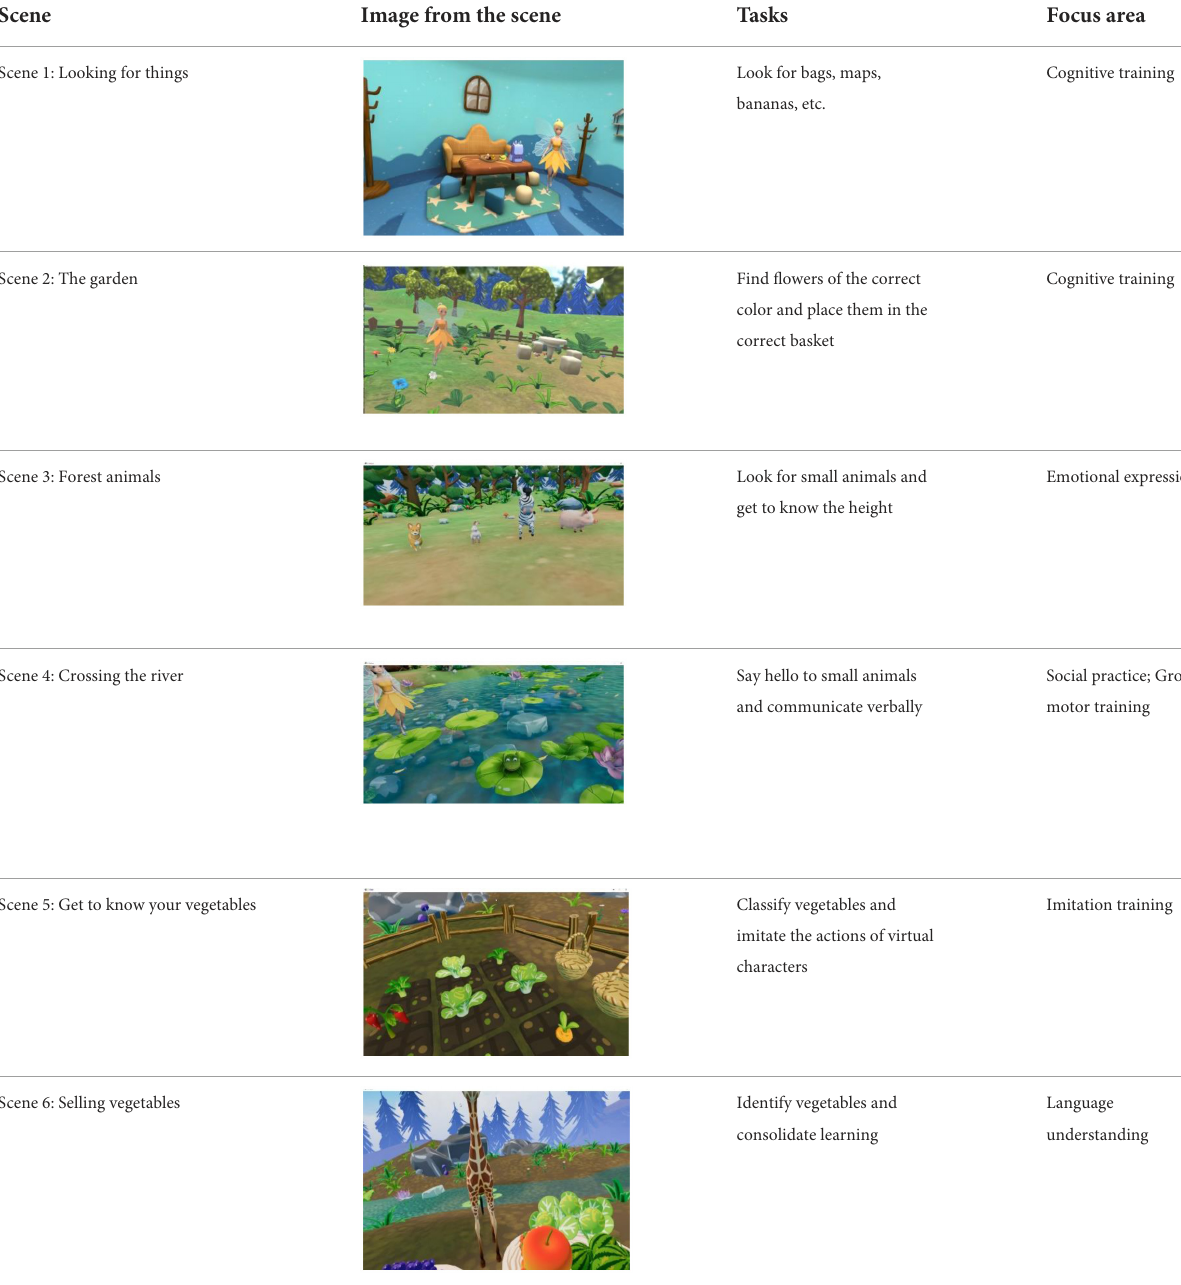
TABLE 1 Six virtual reality intervention training scenarios. Scene Image from the scene Tasks Focus area